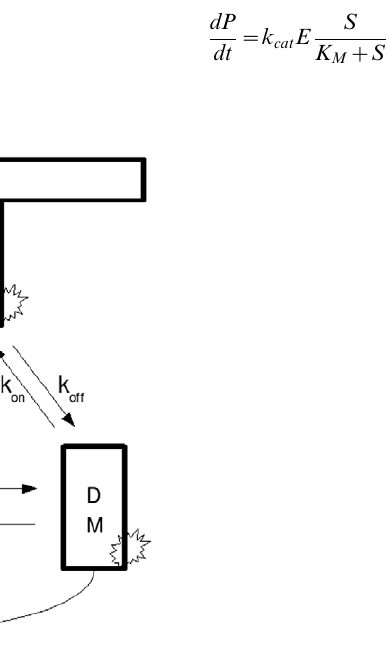
Figure 3. Schematic of activation and deactivation processes in the yeast scaffold-MAPK signaling complex. Names are as given in table 3, with the star representing phosphorylated (and thus active) Fus3. Horizontal arrows represent phosphorylation/dephosphorylation events (P to D and vice versa and inactive Fus3 to active Fus3 and vice versa), while transitions from the inner layer to the membrane layer are binding reactions ( k on and k off